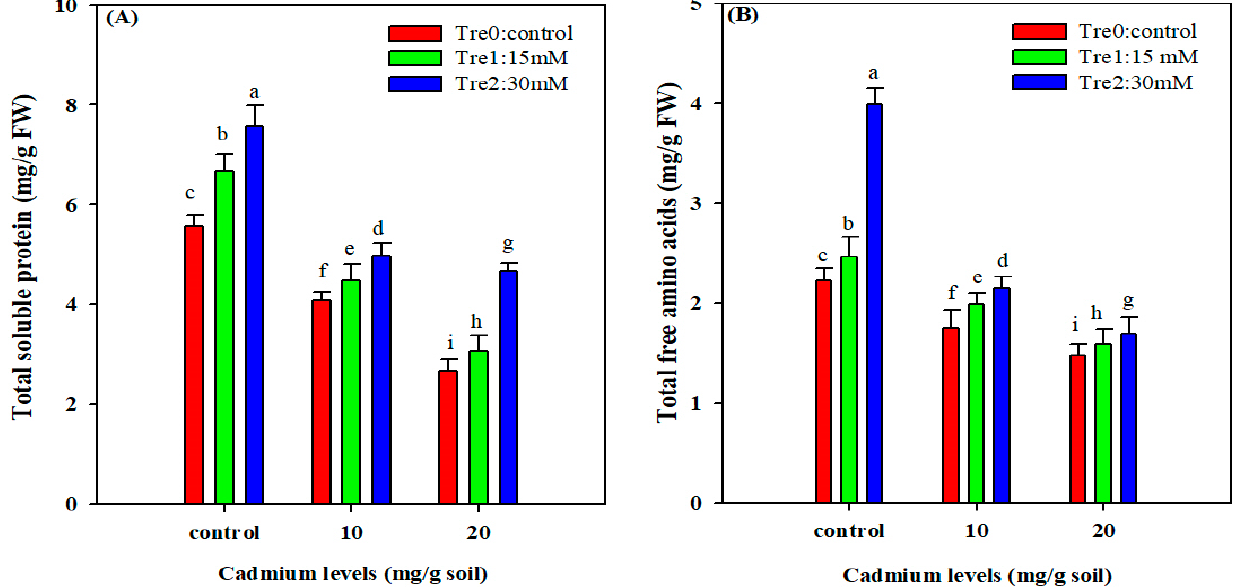
Figure 3. Effect of foliar application of Tre on TSP ( A ); and FAA ( B ) of mung bean plants grown under Cd stress. The values given in vertical bars are showing the mean of three replicates with ± S.E and the different letters above the bars under the same treatment show the significant differences at p < 0.05.